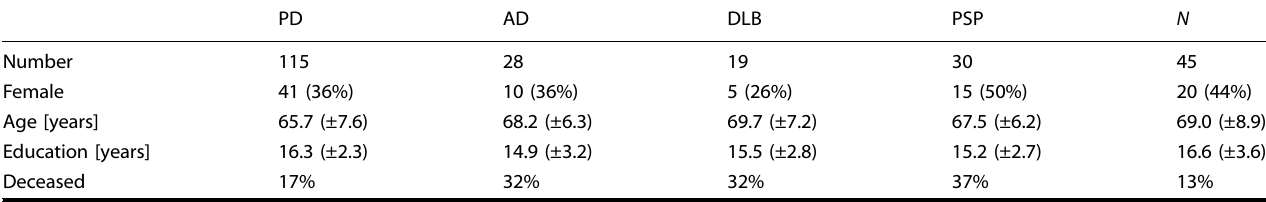
Table 1. Demographic information on patients and controls that donated CSF samples.